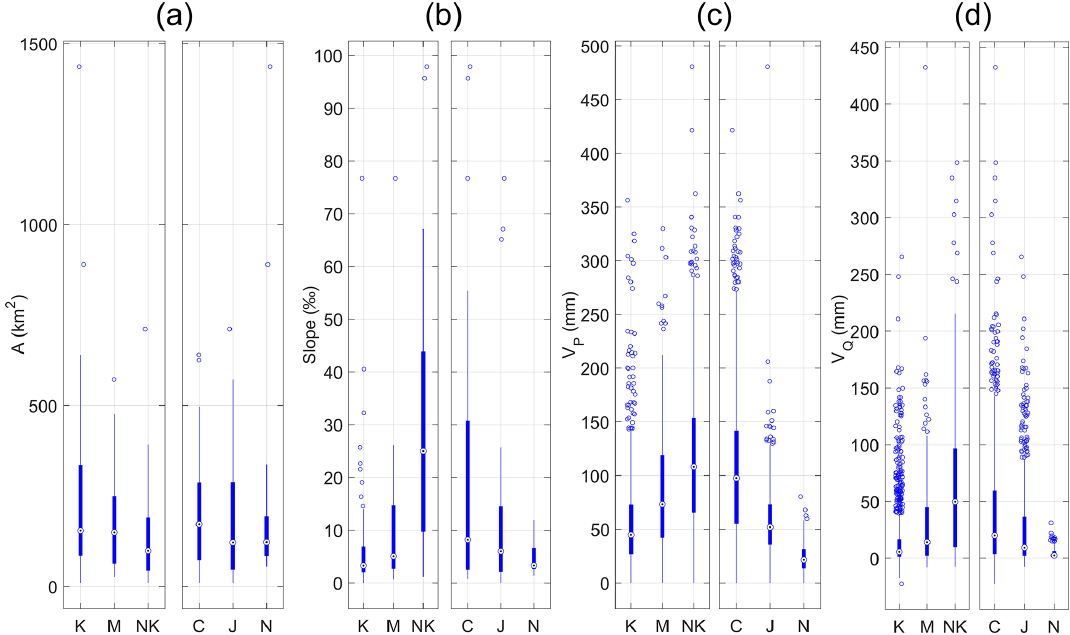
Figure 5. Elementary catchment area (a) ; reach mean slope (b) distribution of the 108 gauging stations, grouped by geology type (K: karst, M: mixed, NK: non-karst) and by study area (C: Cévennes, J: Jura, N: Normandy) for K catchments. Precipitation (c) and runoff (d) depth distribution for the 20 selected storm events on the 108 gauging stations, grouped by geology type and study area for K catchments. Values beyond dashed lines are represented on the